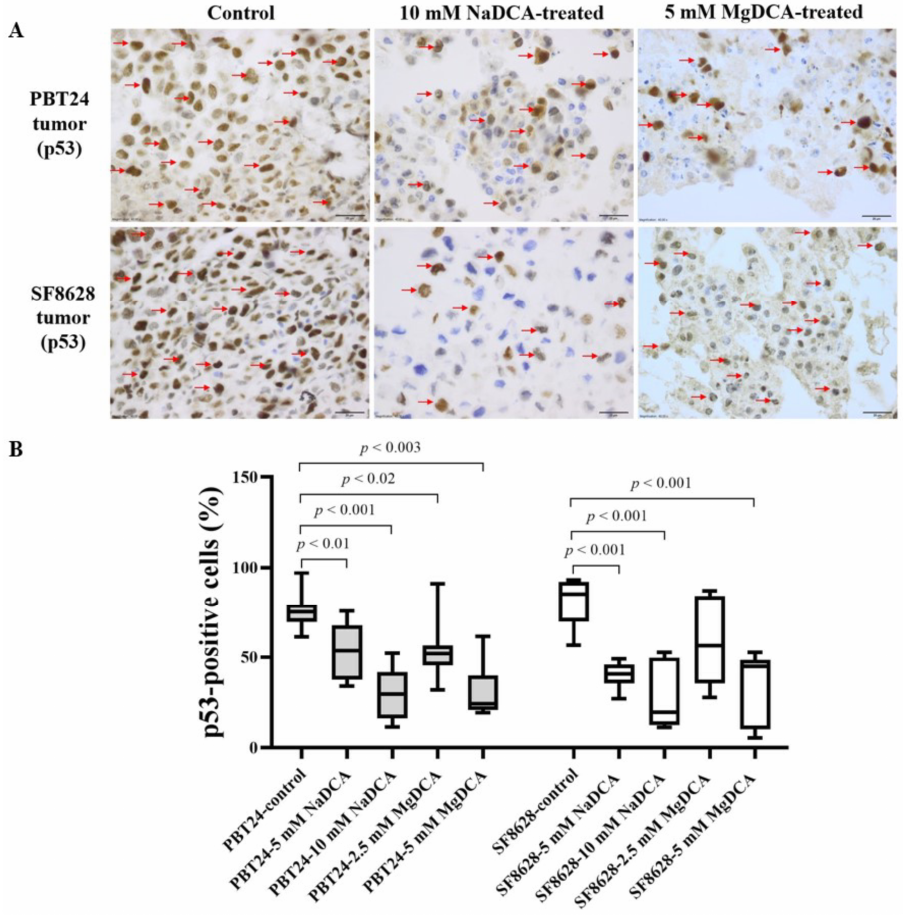
Figure 6. Immunohistochemical expression of p53 in control and DCA-treated tumor groups. ( A ) Dark brown nuclei indicate p53-positive cells (red arrows). The magnification is 40 × , scale bar is 20 µ m. ( B ) The percentage of p53-positive cells in PBT24 and SF8628 tumors. 2.6. The Survivin Expression in the Control and DCA-Treated PBT24 and SF8628